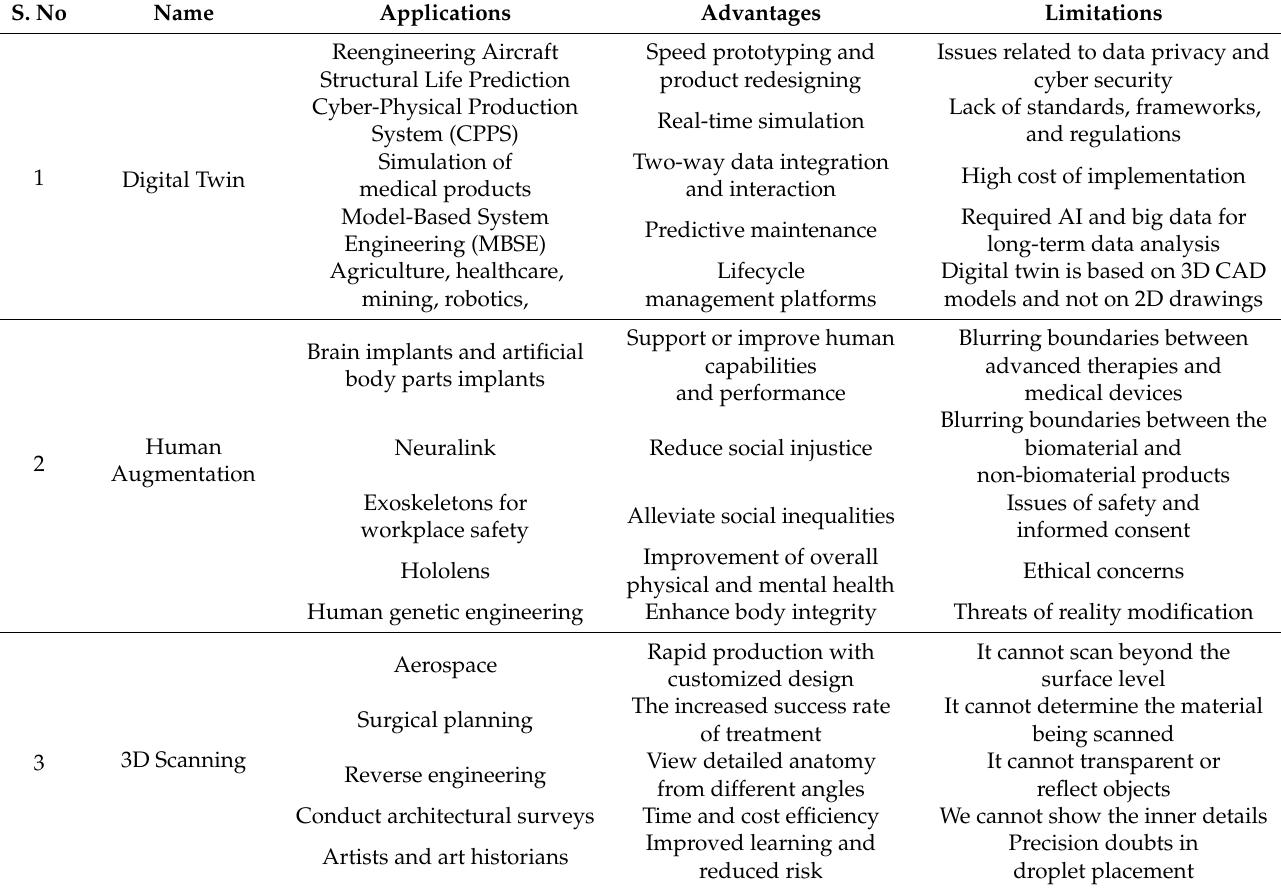
Table 1. IoT-enabled AM Applications, Advantages, and